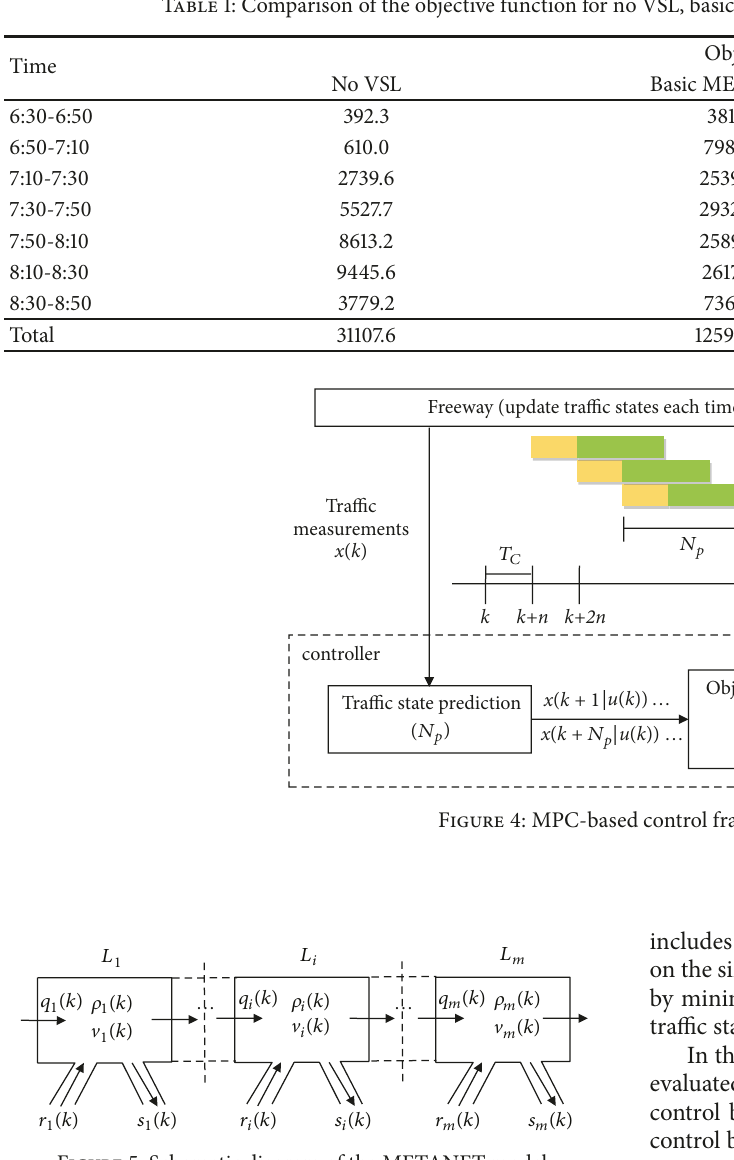
Figure 5: Schematic diagram of the METANET